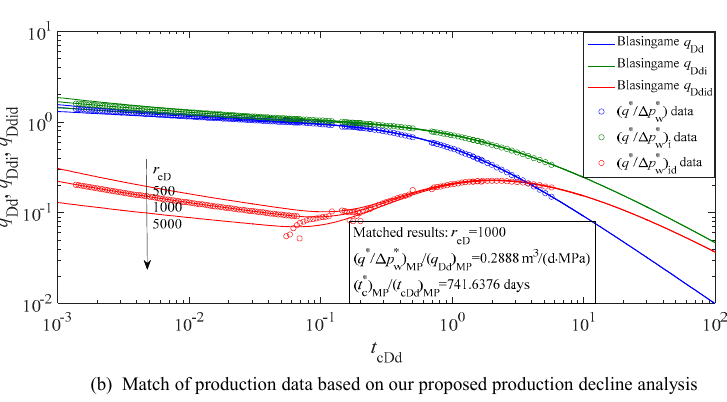
(b) Match of production data based on our proposed production decline Figure 27. Match of production data for Case 4. Table 10. Comparison between the results obtained by BPDA and PPDA for variable-rate/pressure cases. Parameter